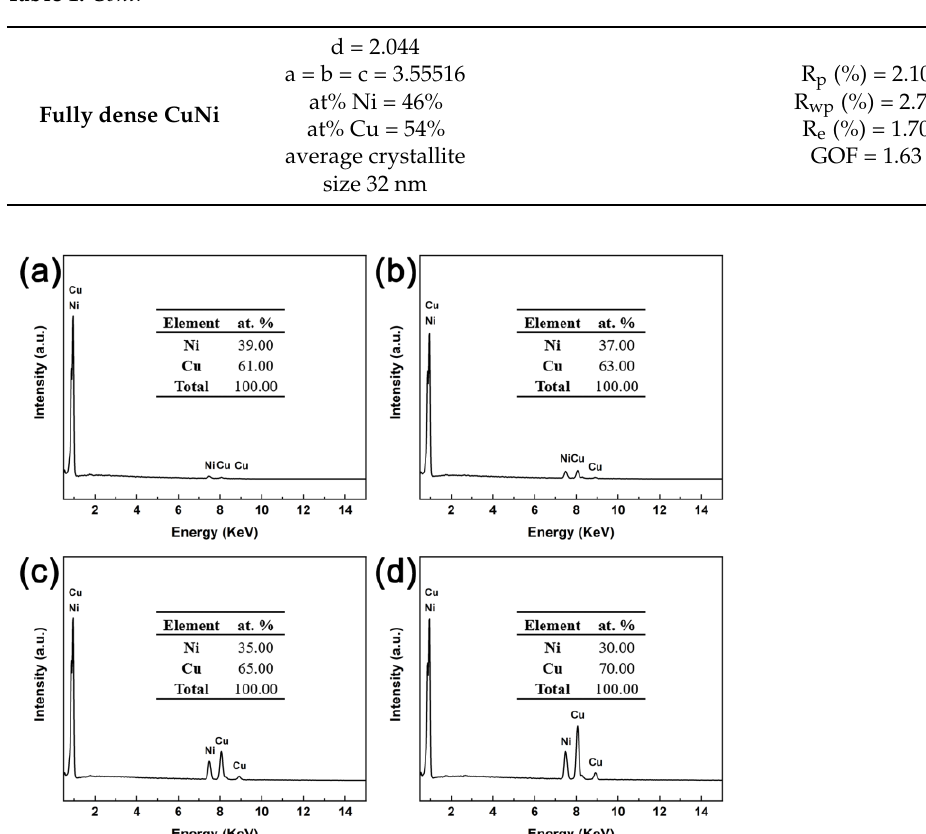
Figure 3. EDX spectra of porous CuNi film carried out under different accelerating voltages: ( a ) 10 kV, ( b ) 12 kV, ( c ) 15 kV, ( d ) 18 kV.